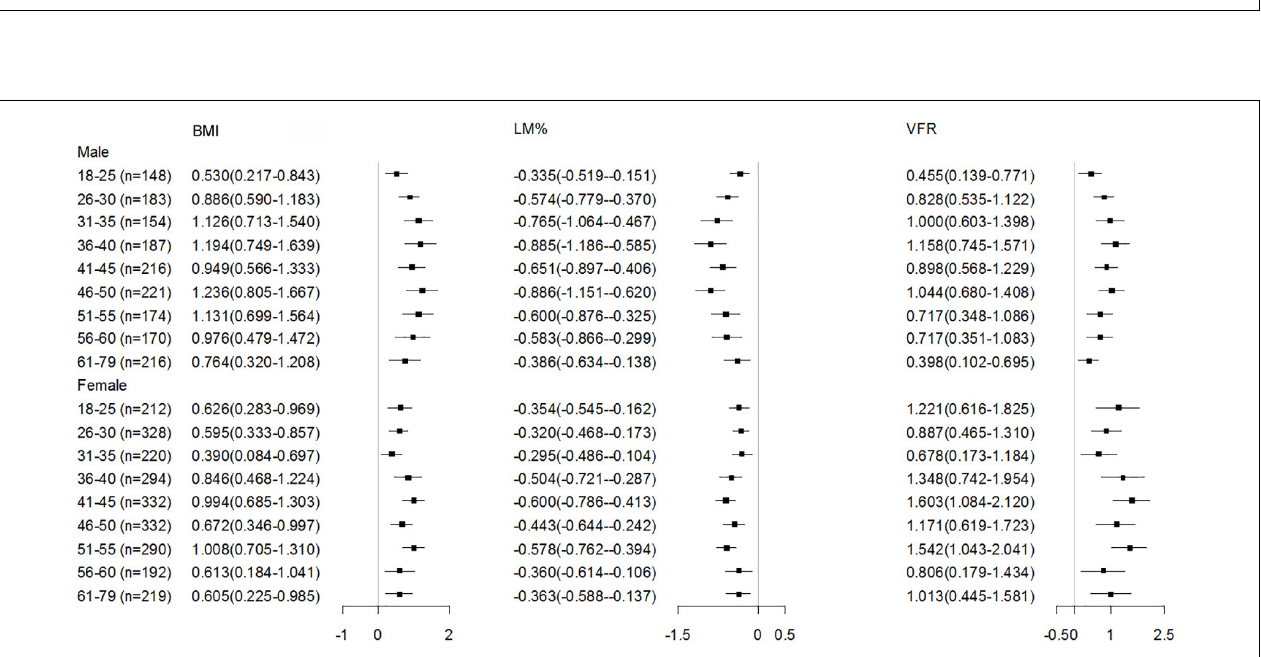
FIGURE 2 | Adjusted regression coefficients of body composition indices by SBP in the subjects b (95% CI) was obtained from multiple linear regression analysis, adjusted for education, smoking and drinking status, and residential location. BMI, body mass index; LM%, lean mass percentage; VFR, visceral fat rating; SBP, systolic blood pressure.